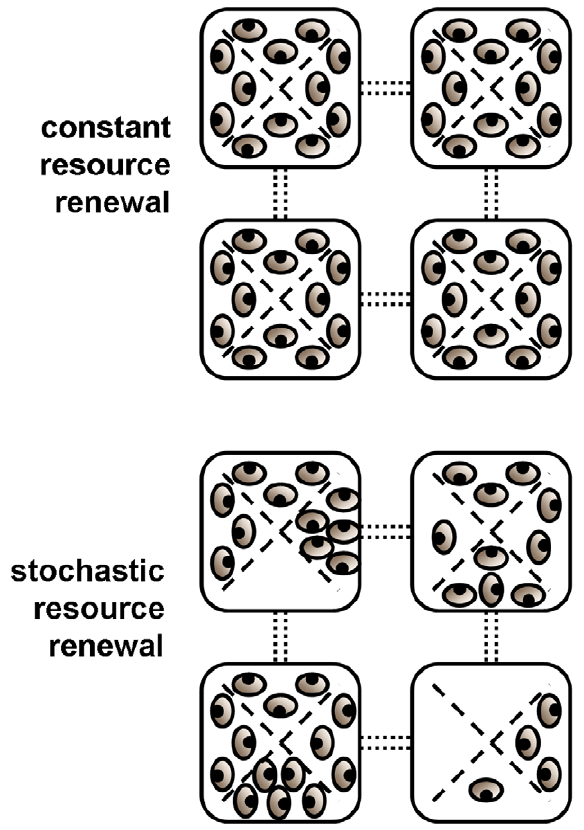
Figure 1. Plan view of four patch, square lattice, metapopula- tion design: dotted connectors indicate dispersal routes between patches (boxes); dashed lines represent barriers separating weekly host resource (bean) quantities but which did not impede insects. Beans were renewed on a four week regime with either constant or stochastic renewal. Long term average resource levels were two, three or four beans per patch, depending on renewal treatment (average three beans